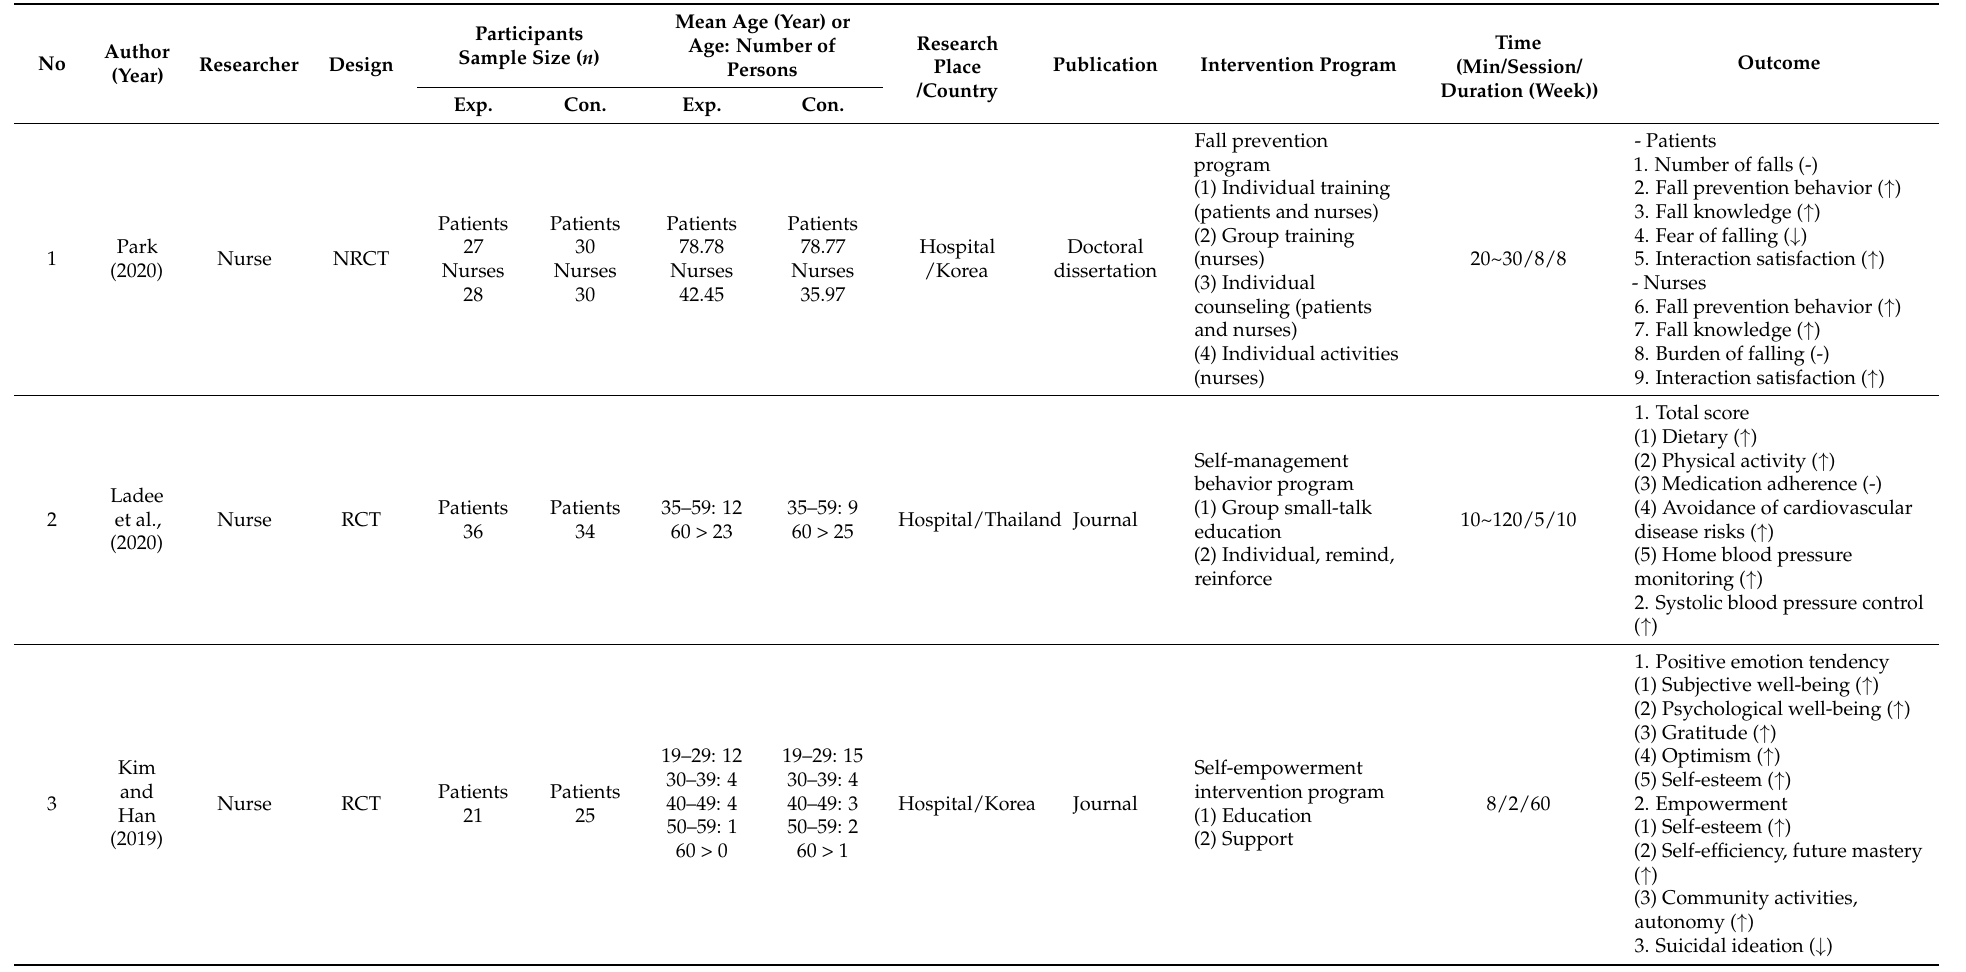
Table 1. Characteristics of the included studies